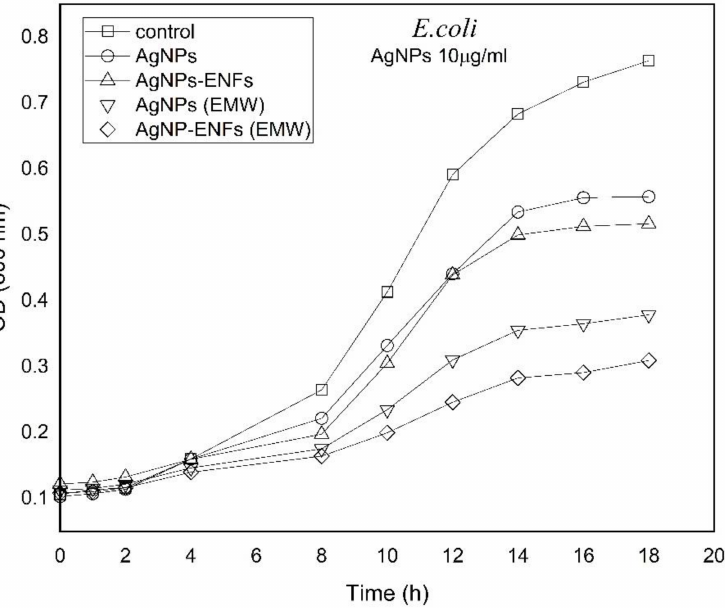
Figure 7. Time-dependent growing characteristic curves of E. coli after supplement by (10 µ g/mL) Ag NPs alone, Ag NPs-ENFs, and combined with